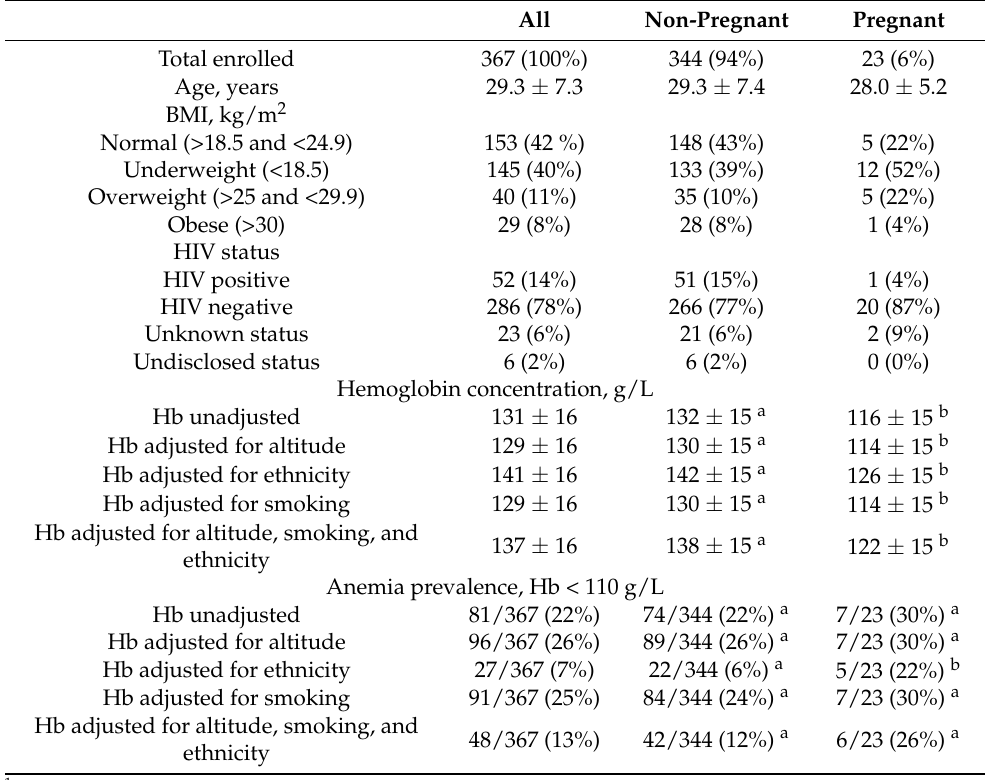
Table 2. Anemia prevalence, BMI, and HIV status of enrolled San women in rural Botswana 1 . All Non-Pregnant Pregnant Total enrolled 367 (100%) 344 (94%) 23 (6%) Age, years 29.3 ± 7.3 29.3 ± 7.4 28.0 ± 5.2 BMI, kg/m 2 Normal (>18.5 and <24.9) 153 (42 %) 148 (43%) 5 (22%) Underweight (<18.5) 145 (40%) 133 (39%) 12 (52%) Overweight (>25 and <29.9) 40 (11%) 35